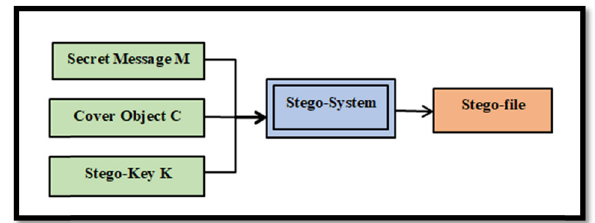
Figure 2: Steganography work fl